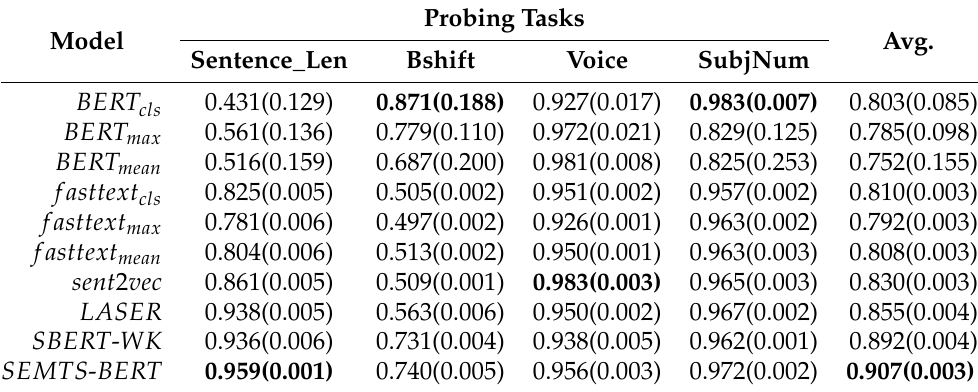
Table 2. The experimental results of different models in probing